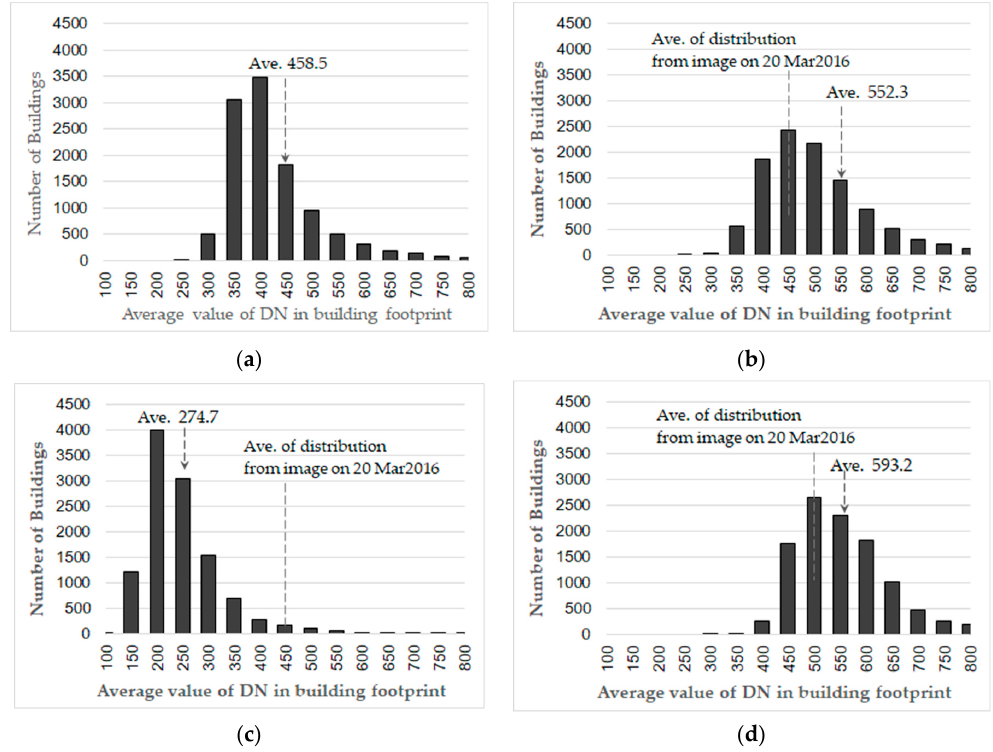
Figure 9. Distribution and average of the digital number (DN) within the building footprints of OSM data from SPOT images observed on: ( a ) 20 March 2016; ( b ) 29 July 2017; ( c ) 1 January 2017; and ( d ) 25 March 2018.